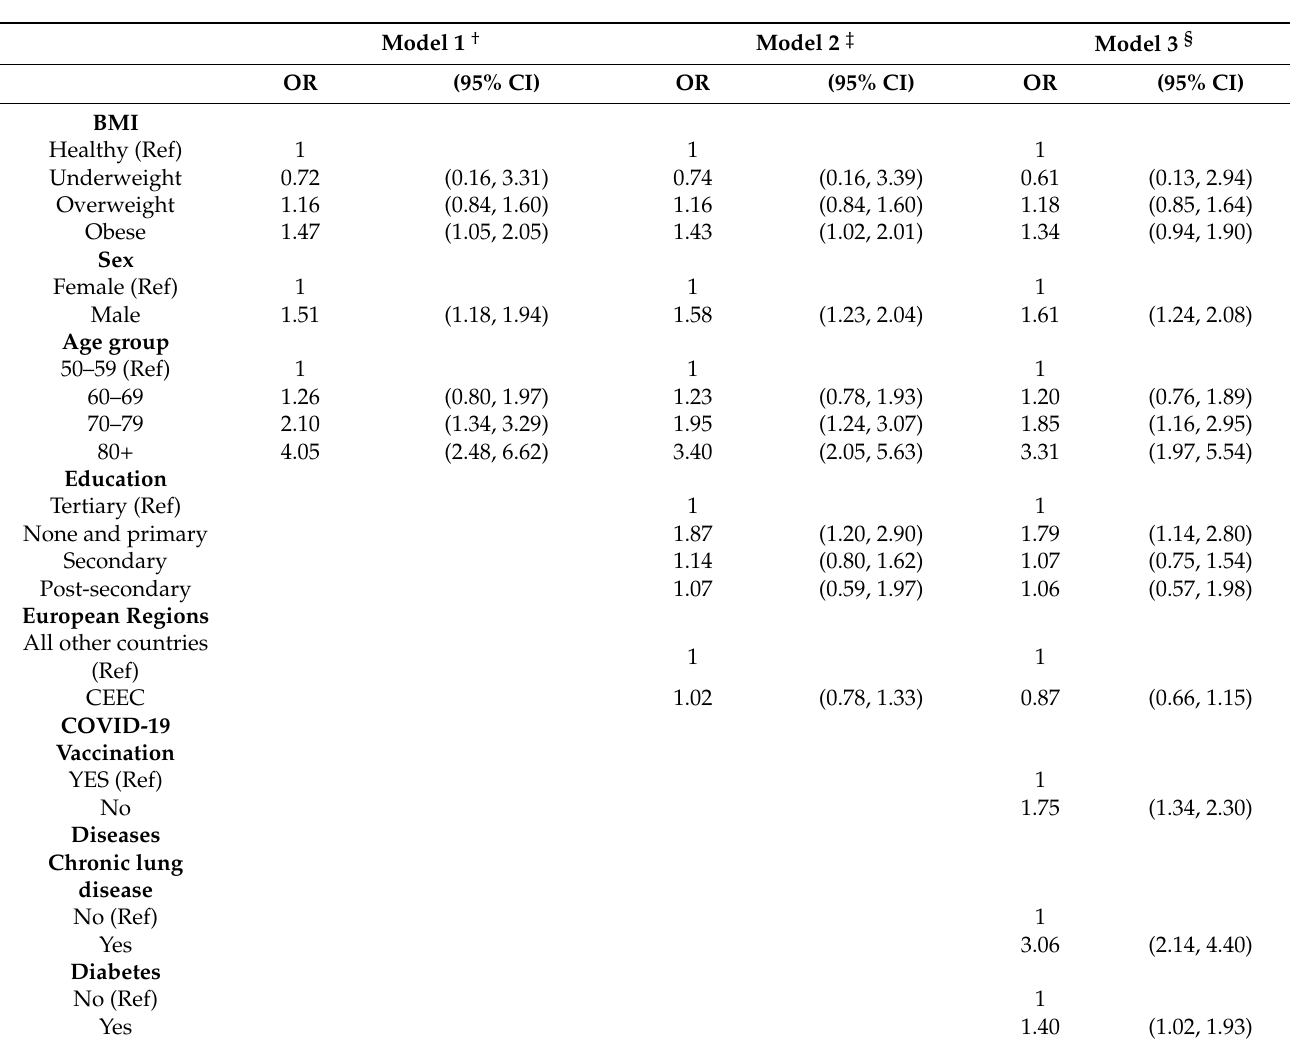
Table 2. Adjusted ORs and 95% CIs of hospitalization due to COVID-19 infection (Study sample, N =